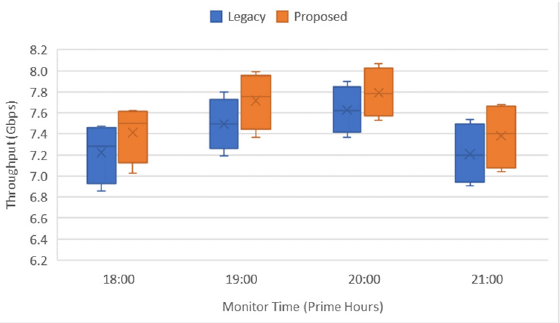
Figure 12. Server leaf switch throughput—All week comparison (input rate).